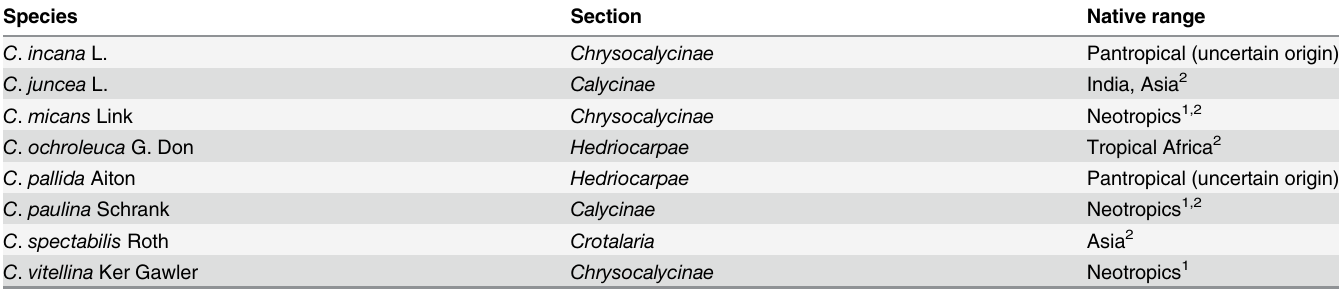
Table 1. Species of Crotalaria used to feed larvae of Utetheisa ornatrix for Nephila clavipes bioassay and PA